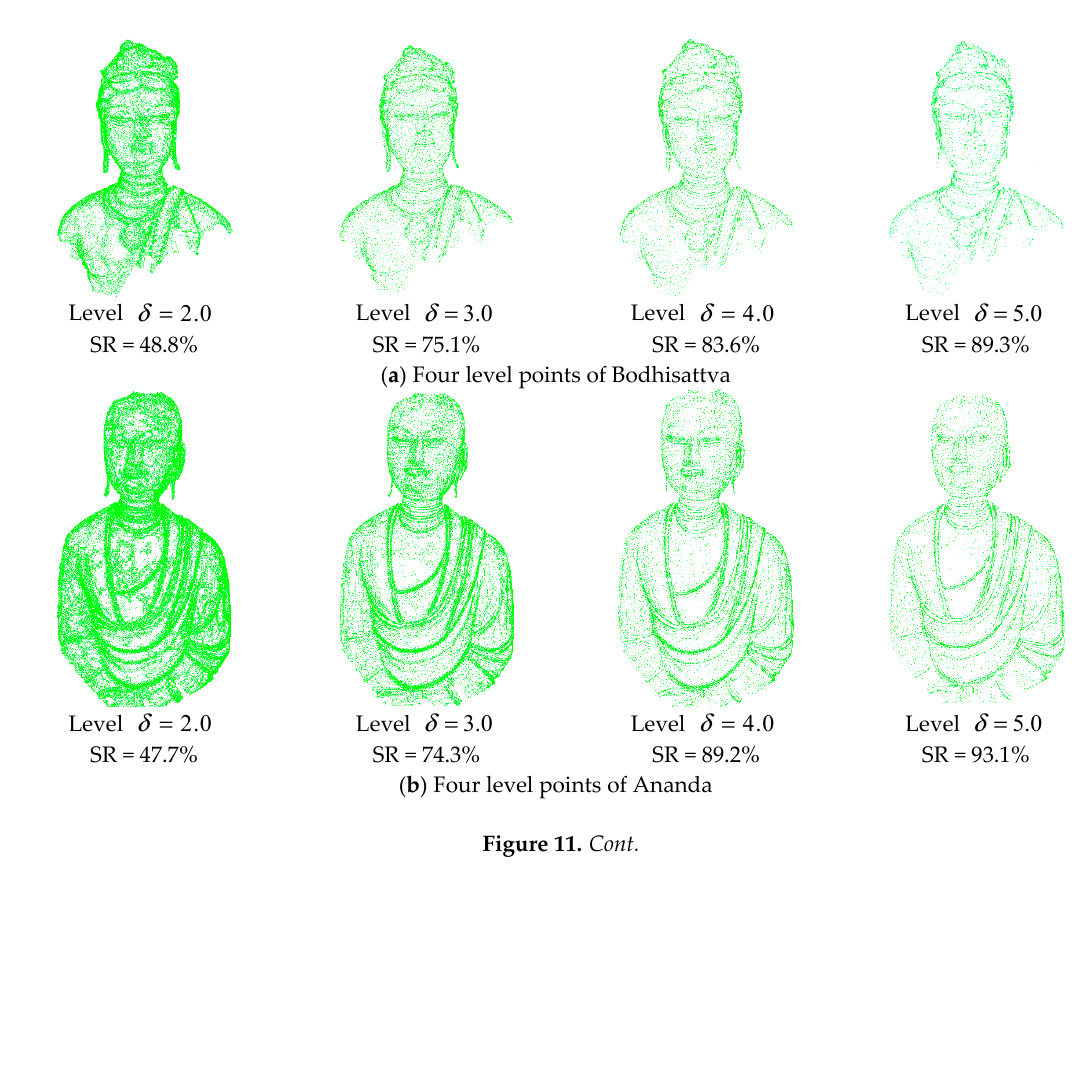
Figure 10. Gaussian smoothing results of three levels and corresponding surface variation